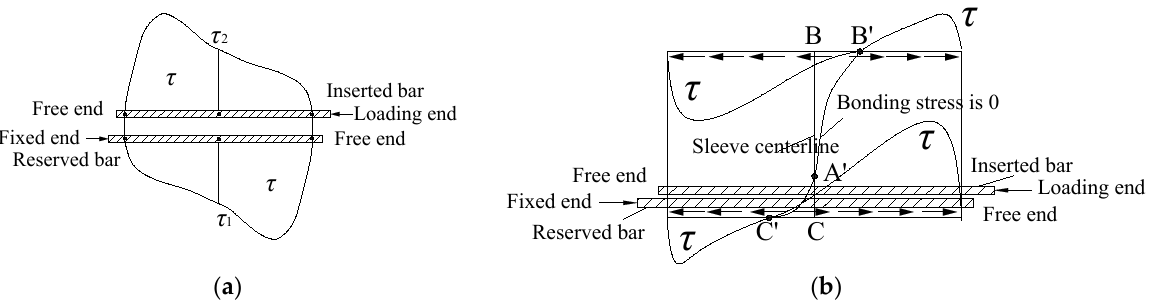
Figure 25. Analysis of the bonding stress of the sleeve in the higher-loading period under compression. ( a ) Bonding stress distribution of steel bar, ( b ) Bonding stress of sleeve.